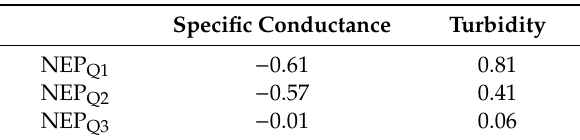
Table 11. Spearman correlation of net ecosystem production (NEP) with water quality data at three locations of the Kanawha River.